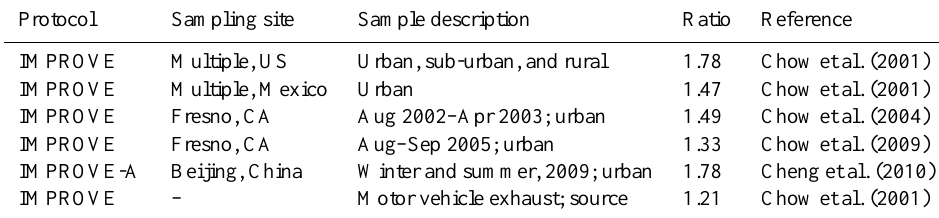
Table 2. Ratios of reflectance-defined EC (EC R ) to transmittance-defined EC (EC T ).